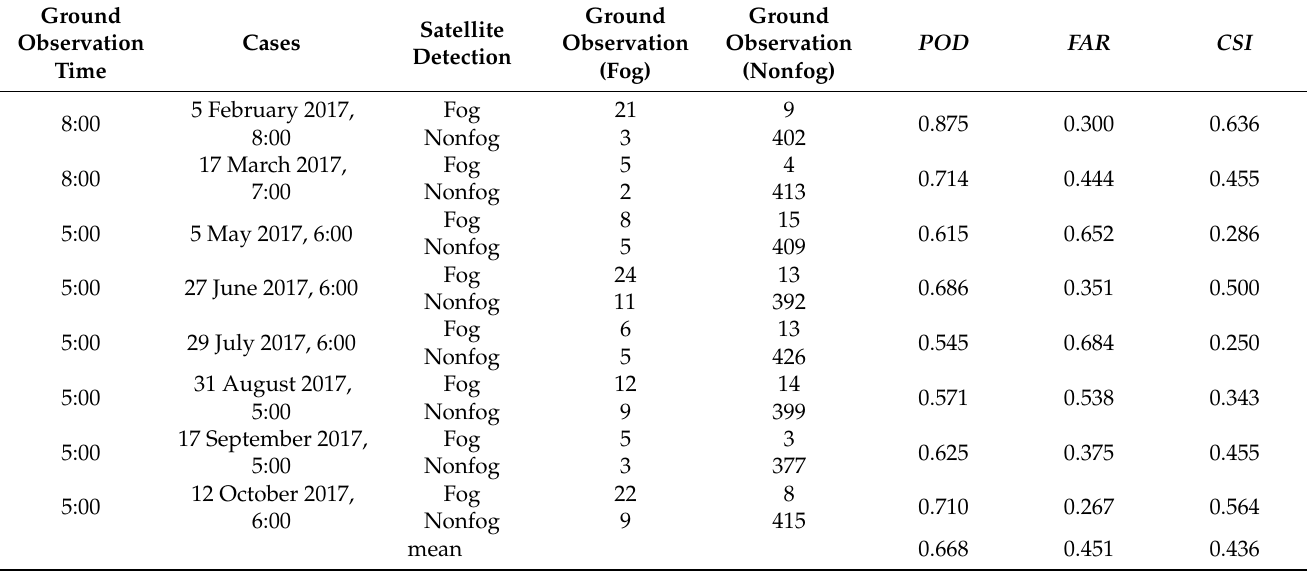
Table 4. Fog detection accuracy at dawn over different